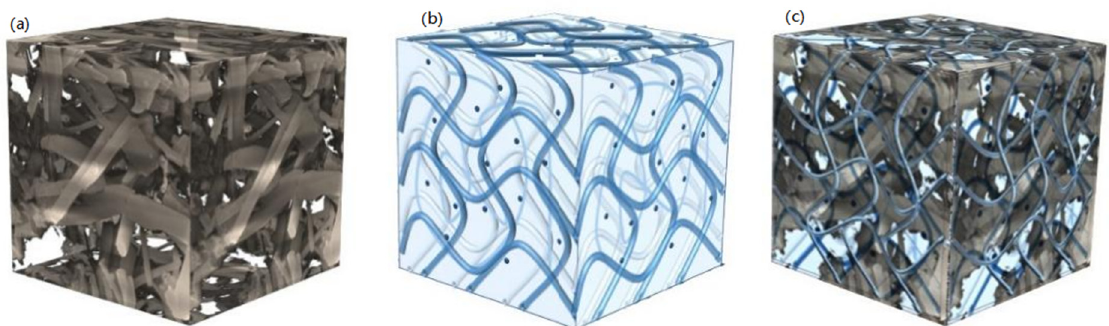
Figure 18. Schematic diagram of AM in situ polymerization of modified sulfoaluminate paste.